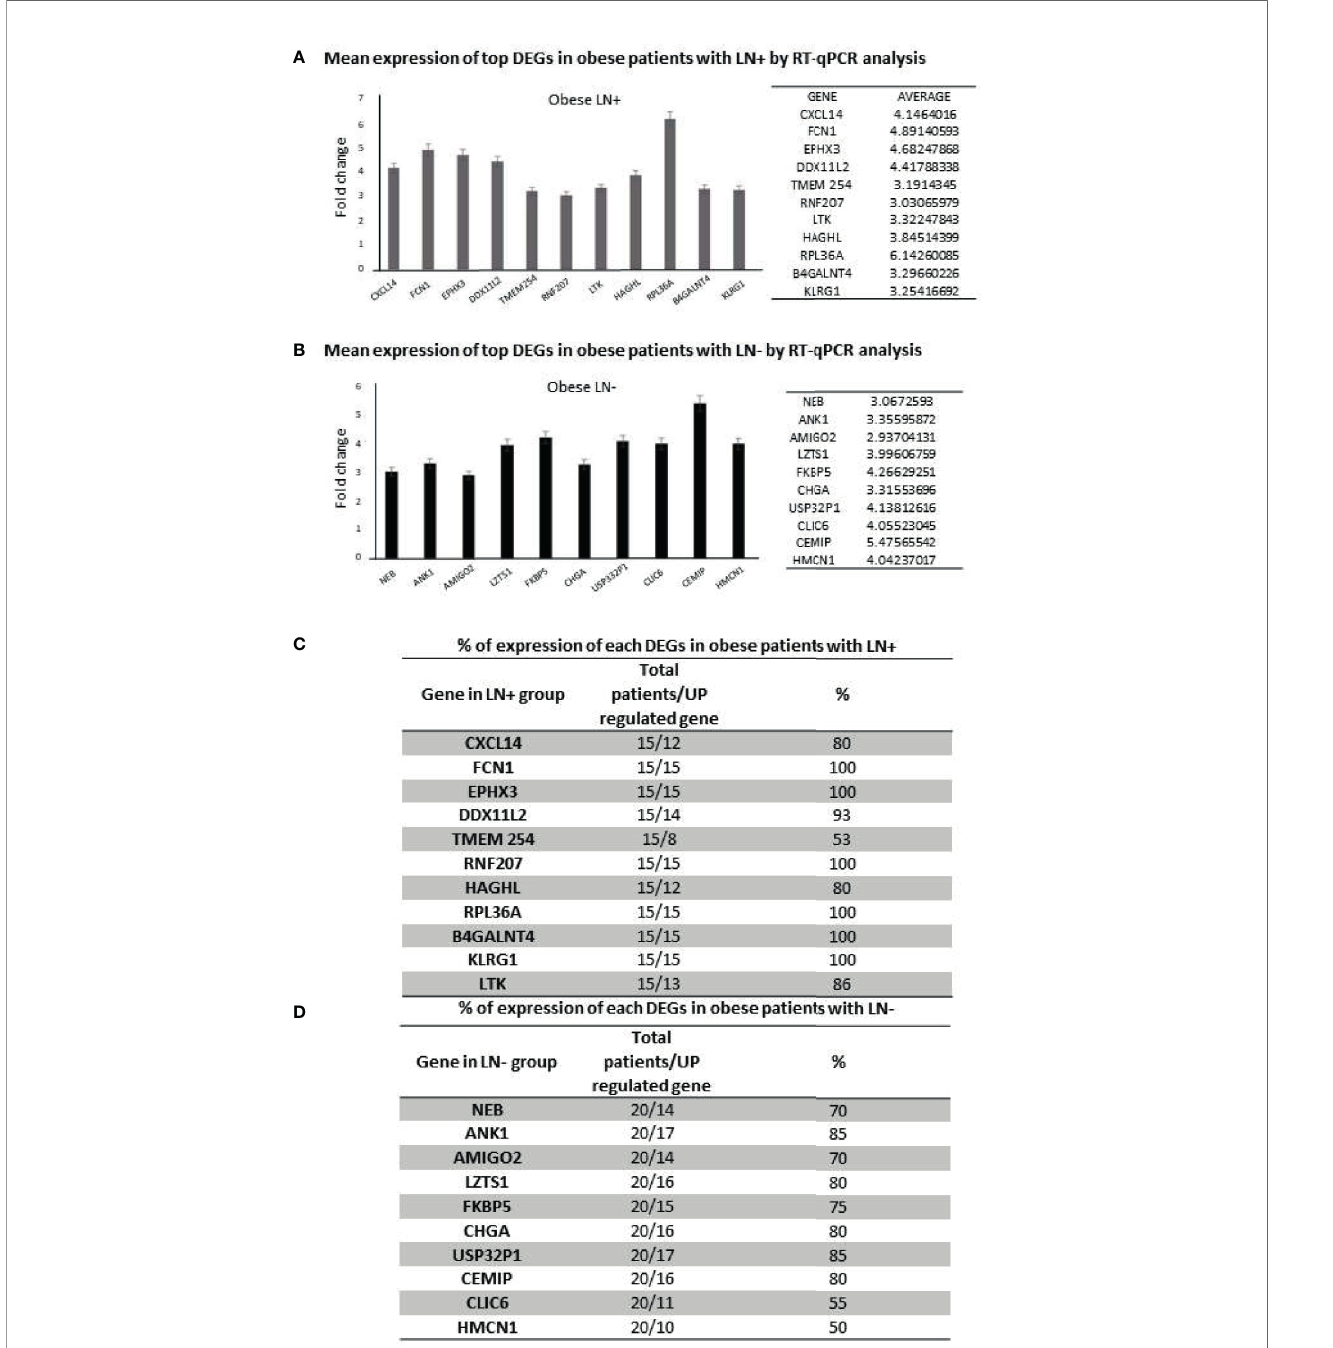
FIGURE 3 | mRNA expression levels (fold change) of the differential expressed genes in (A) obese patients with LN+ and (B) LN- patients, using RT-qPCR analysis. (C) Percentage of expression of the differential expressed genes in patients with LN+ and (D) LN-